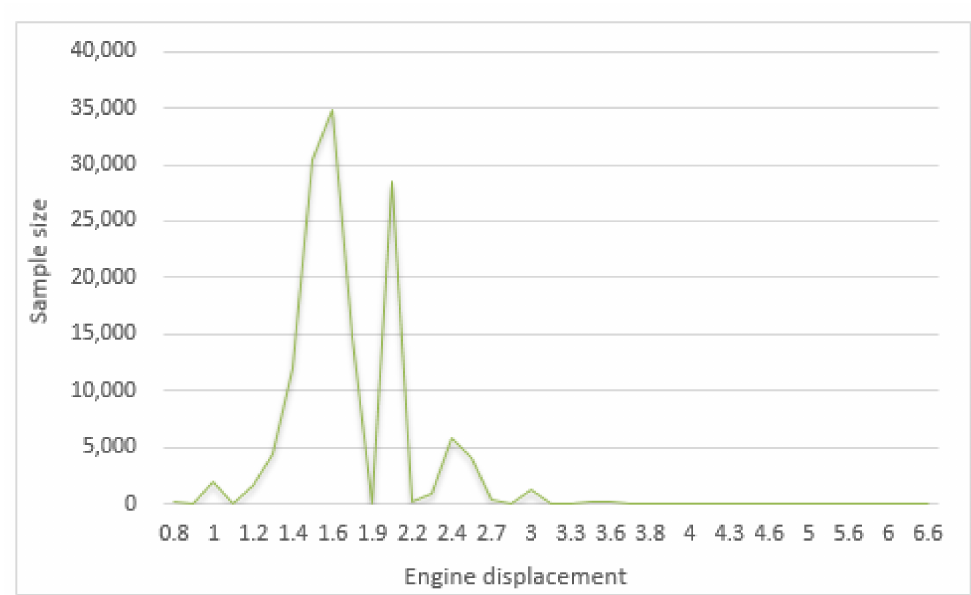
Figure 1. Sample distribution of engine